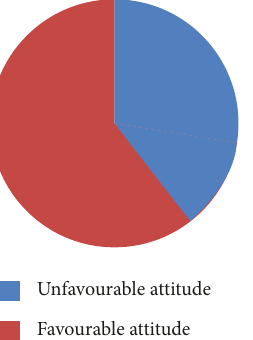
Figure 2: Total distribution of respondents according to their attitude towards COVID-19 in Dessie town, Ethiopia,